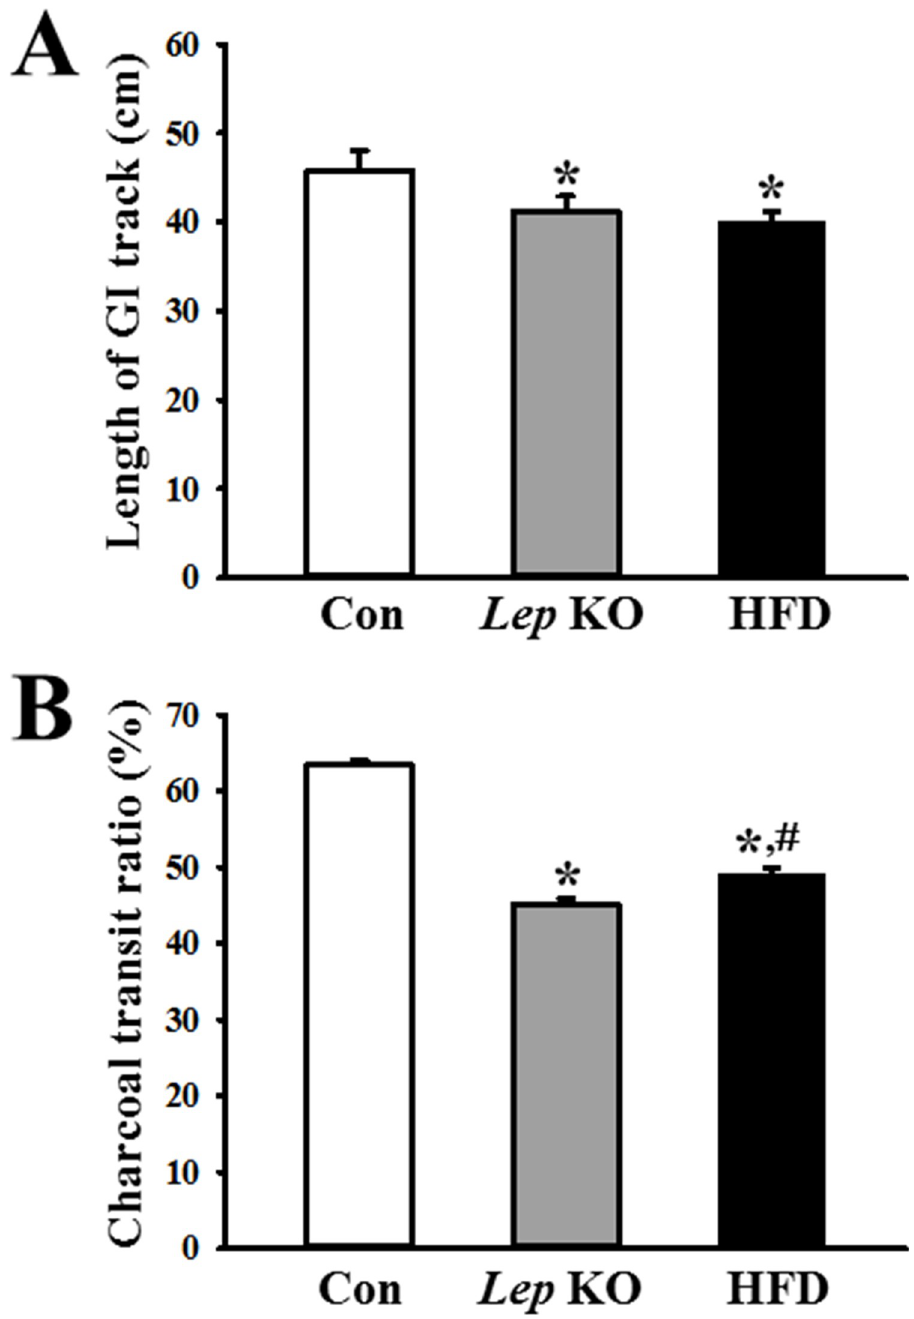
Fig 3. GI tract length and GI transit ratio. (A) Length of the GI tract. Three to five mice per group were used to prepare the GI tract, and their length was measured in duplicate. (B) Charcoal transit ratio. The charcoal meal transit ratio was then calculated using the total length of the intestine and the distance of the charcoal meal. Three to five mices per group were used in the GI transit ratio test, and the charcoal meal transit distance and intestine length were measured in duplicate. The data are reported as the mean ± SD. � indicates p < 0.05 compared to the Con group. Abbreviations: Con, Control group; Lep KO, Leptin knockout mice; HFD, High fat diet; GI,